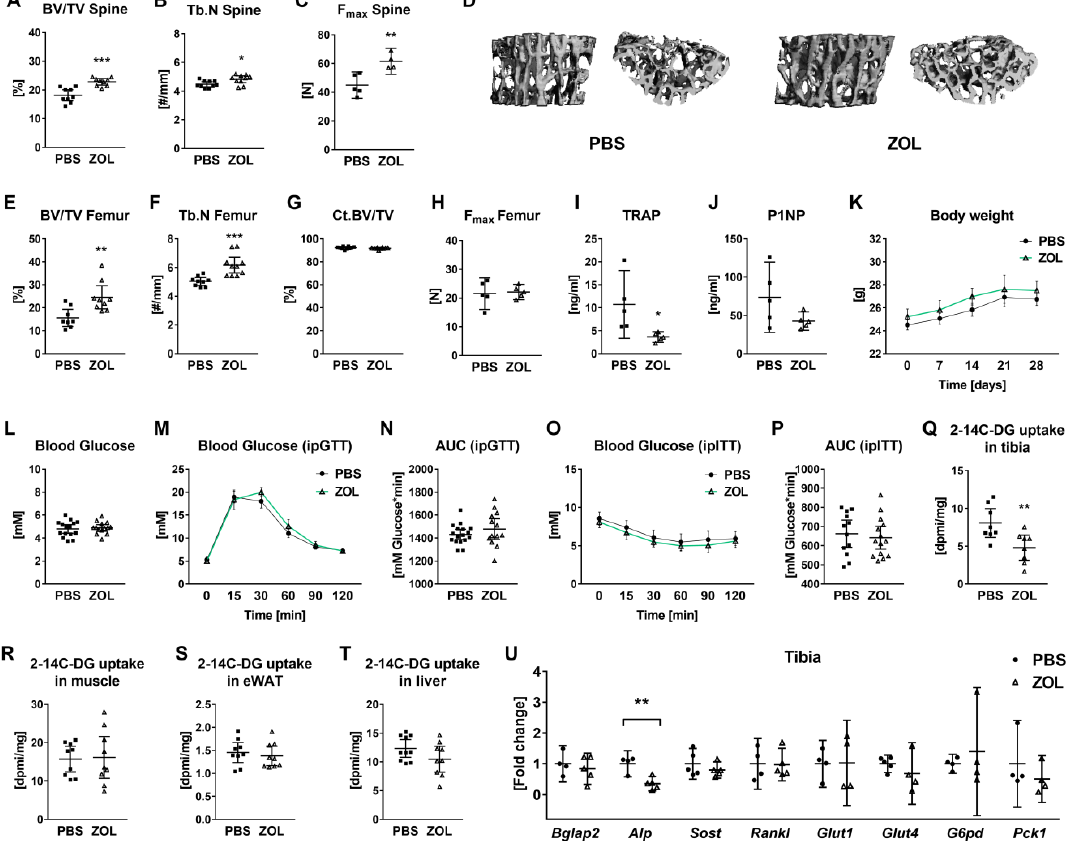
Figure 5. Zoledronate arrests bone resorption but does not affect whole-body glucose metabolism in male mice. Bones from 16-week-old male control mice (CO) and mice treated with zoledronate (ZOL) were tested by microCT. At the spine, ( A ) bone volume/total volume (BV/TV) and ( B ) trabecular number (Tb.N) were assessed. ( C ) Vertebral bone strength indicated by F max was determined by a compression test of the L5 vertebra. ( D ) Representative 3D reconstructions of the trabecular compartment of L4 vertebrae from ZOL-treated and control mice. Furthermore, ( E ) BV/TV and ( F ) Tb.N were measured in the distal femur. ( G ) Cortical bone volume/total volume (Ct.BV/TV) was determined at the femoral midshaft. As an indicator of cortical bone strength, ( H ) maximal force (F max ) was quantified by 3-point bending test of femurs. In addition, serum concentrations of ( I ) bone formation marker P1NP and ( J ) bone resorption marker TRAP were measured using ELISAs. ( K ) Body weights were monitored throughout the 4-week experiment. ( L ) After 16 h of fasting, blood glucose levels were assessed from tail vein blood prior to intraperitoneal glucose tolerance test (ipGTT). ( M ) ipGTT started with ip injection of a 20% v/v glucose solution. Blood glucose concentrations were quantified at indicated times up to 2 h and ( N ) the area under the curve (AUC) was calculated to compare glucose tolerance of hypothyroid and control mice. ( O ) Furthermore, intraperitoneal insulin tolerance testing (ipITT) was performed and ( P ) AUC was calculated based on blood glucose levels over time. 2-[14C]-Deoxy-Glucose (2-14C-DG) uptake was determined in ( Q ) tibia, ( R ) muscle, ( S ) epididymal WAT (eWAT), and ( T ) liver. ( U ) mRNA expression of Bglap2 , Alp , Sost , Glut1 , Glut4 , G6pd, and Pck1 in tibia bone tissue obtained from control and ZOL-treated mice was quantified by real-time PCR. Each dot indicates an individual mouse. The horizontal lines represent the mean ± 95% CI. MicroCT analysis: N = 10 per group; biomechanical testing: N = 5 per group; ELISA: N = 5 per group; real-time PCR: N = 5 per group; body weight curves: N = 16 per group; fasting blood glucose: N = 15 per group; ipGTT: PBS: N = 16, ZOL: N = 13; ipITT: PBS: N = 12, ZOL: N = 14; 2-14C-DG uptake: PBS: N = 10, ZOL: N = 9. Statistical analysis was performed by Student’s t -test: * p < 0.05; ** p < 0.01; *** p < 0.001 vs. control.